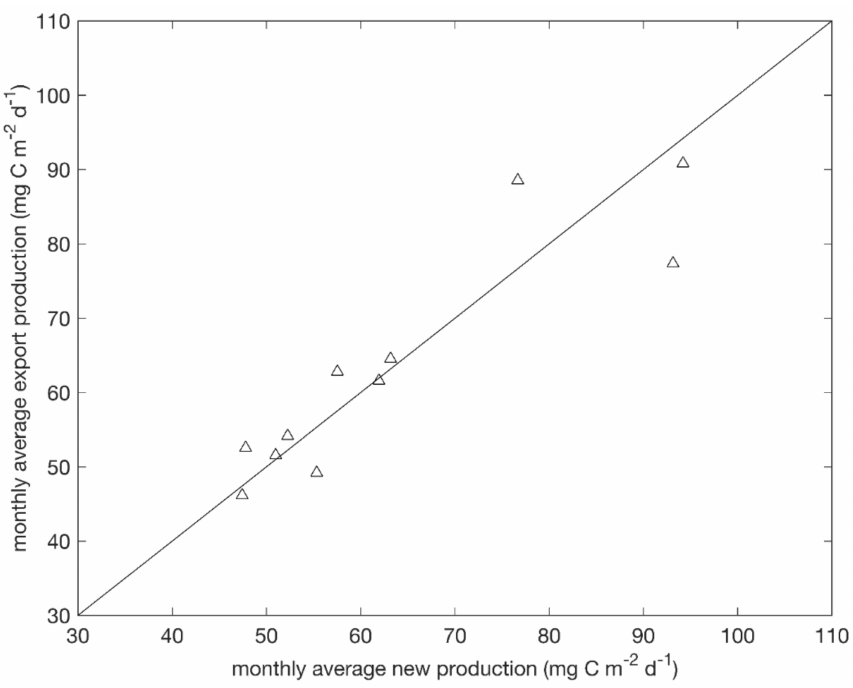
Figure 8. Monthly average new production versus monthly average export production at a depth of 60 m at Station ALOHA, calculated from the simulation results shown in Figure